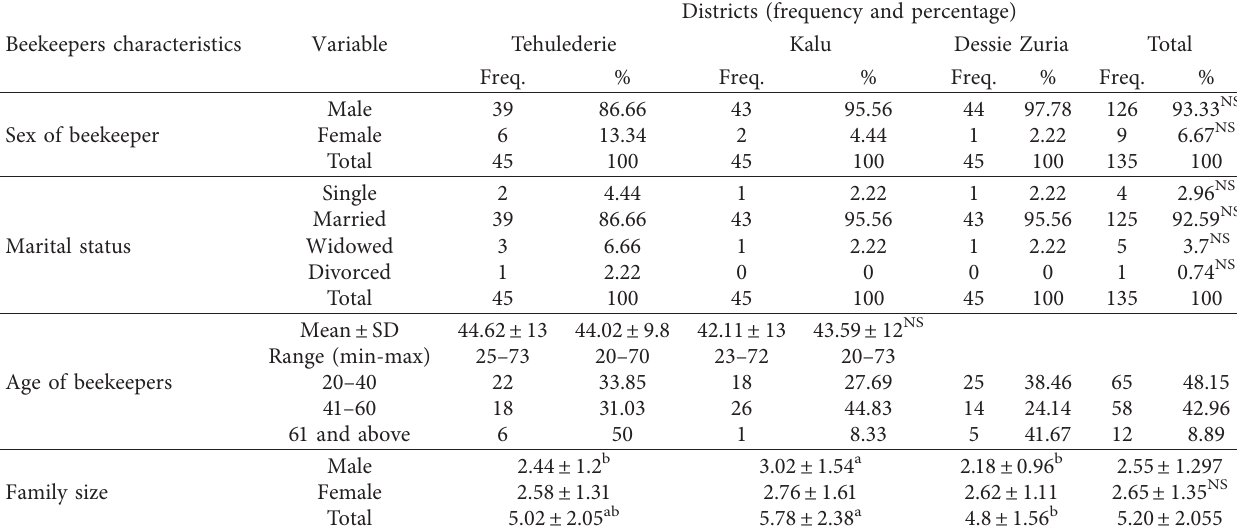
Table 1: Characteristics of the sample beekeeper respondents by districts. Beekeepers characteristics